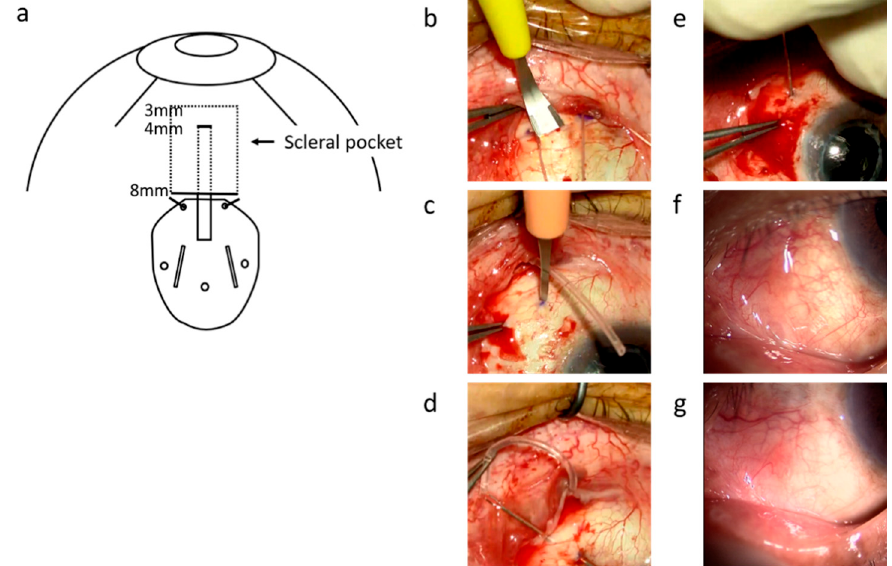
Figure 1. The surgical technique for tube insertion into the vitreous cavity through a scleral pocket. ( a ) is a schematic diagram of this surgery. The sclera was marked at 4 mm and 8 mm posterior to the limbus with a surgical pen. The episcleral suture for anchoring the AGV plate was placed 8 mm posterior to the limbus using 5-0 Dacron suture. The scleral pocket was made using a crescent knife (Mani, Tochigi, Japan) from 8 to 3 mm posterior to the limbus ( b ). The sclerotomy was created 4 mm posterior to the limbus with a side port straight knife (SP-S30, KAI, Tokyo, Japan) ( c ). The 27-gauge MaxGrip forceps (Alcon, Geneve, Switzerland) were passed through scleral pockets from the sclerotomy site, and the tip of the tube was grabbed with the forceps ( d ). The tube was inserted into the vitreous cavity through the sclerotomy site ( e ). Photographs of the anterior segment one month ( f ) and one year ( g ) after the surgery show smooth surface of the conjunctiva and absence of conjunctival dissociation and tube exposure.